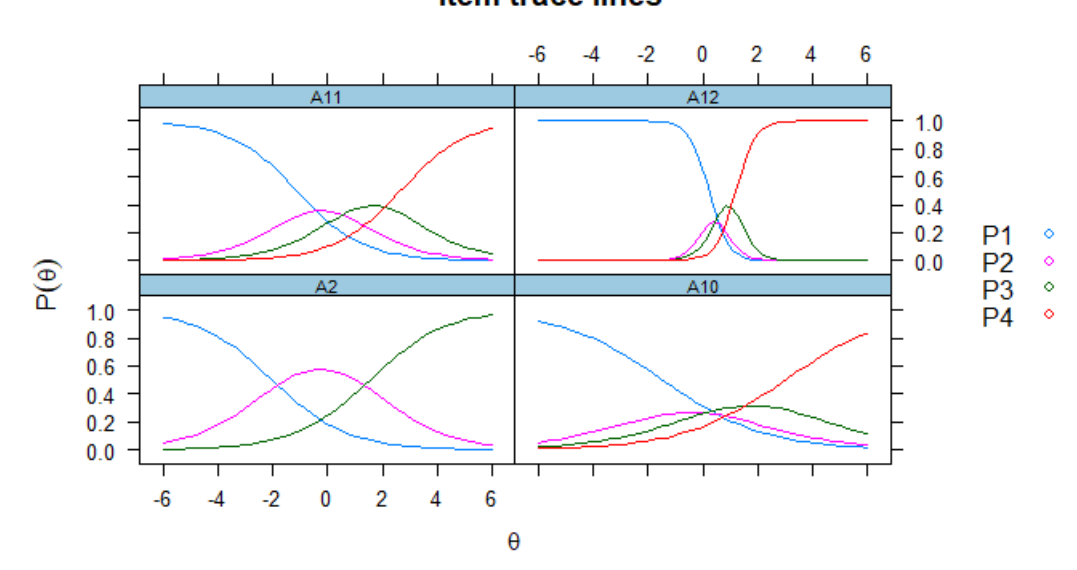
Figure 6. ICCs of the Existential Needs component.